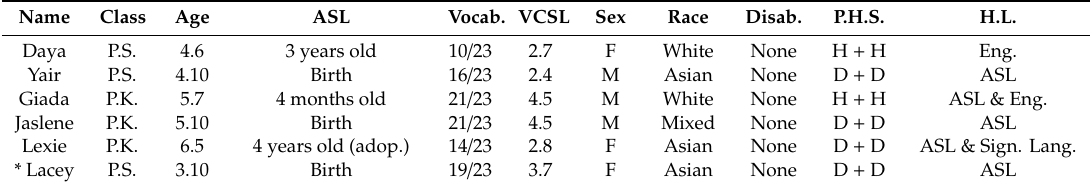
Table 1. Student Participants’